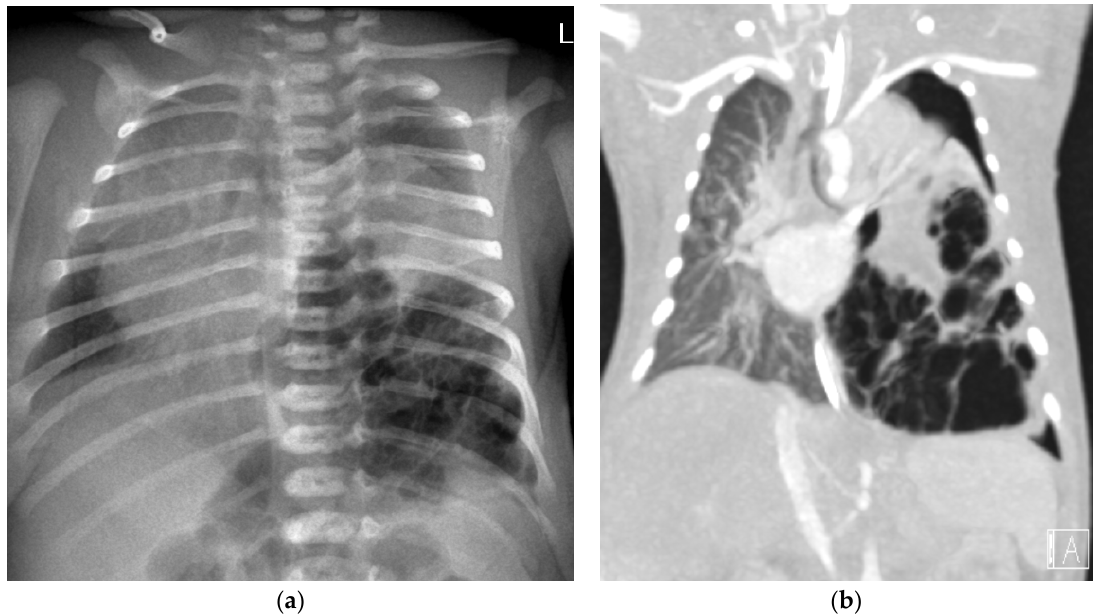
Figure 3. Two-day-old infant with respiratory distress. ( a ) Chest X-ray and ( b ) Coronal image of CTA: Large multilocular cystic lesion in the right lower hemithorax, with mediastinal shift to the right. There is an atelectasis of the left upper lung and apical pneumothorax.